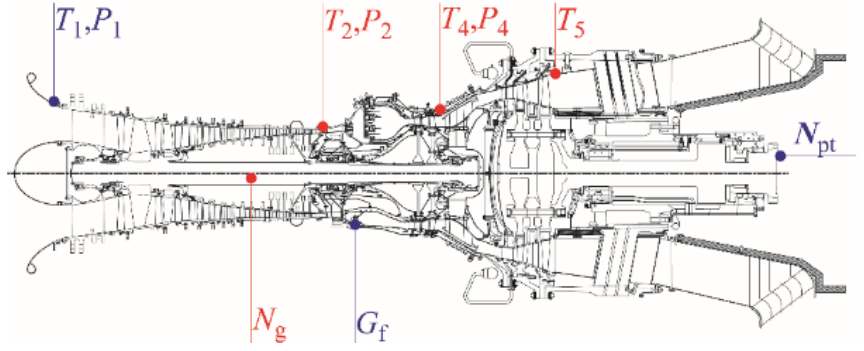
Figure 4. Schematic of gas turbine and measurement parameters.